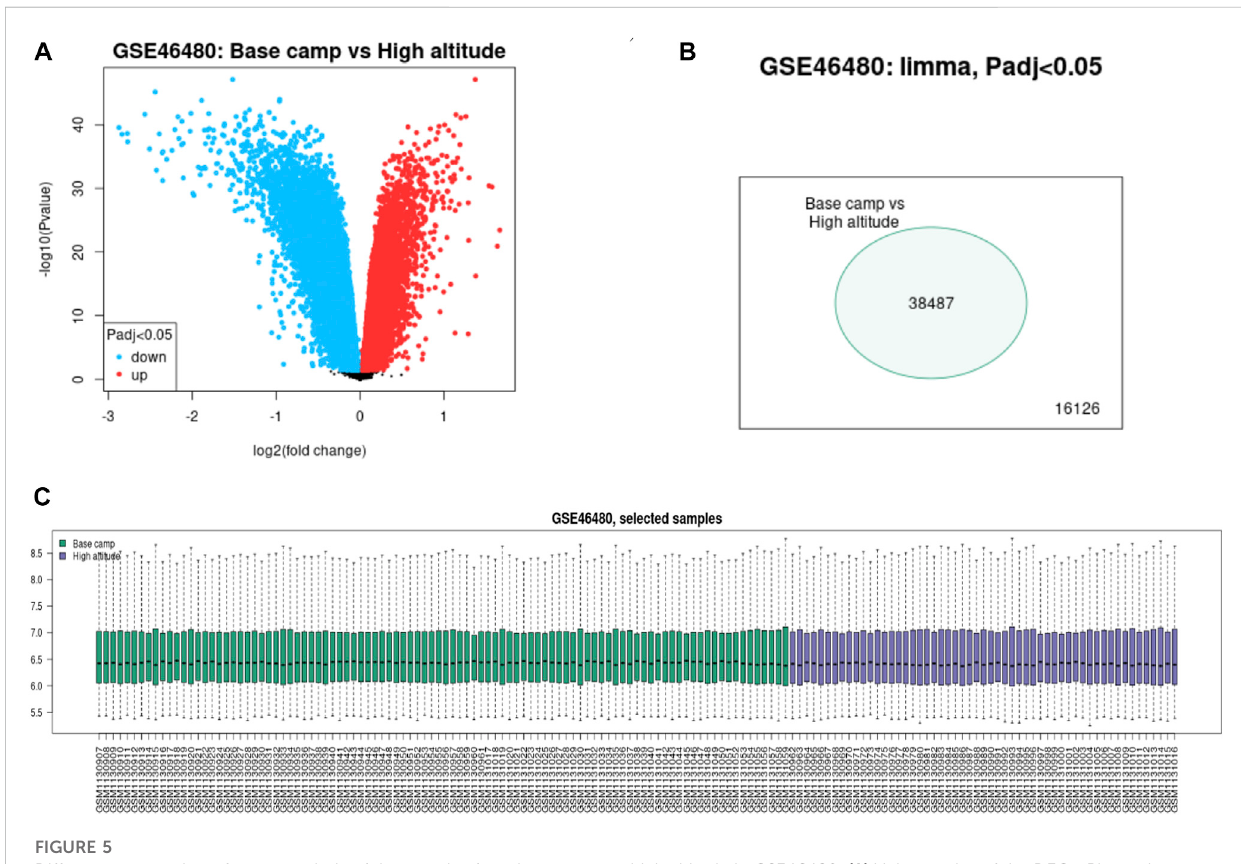
FIGURE 5 Difference expression of genes analysis of the samples from base camp to high altitude in GSE46480. (A) Volcano plot of the DEGs. Blue points represent downregulated genes. Red points represent the upregulated genes. (B) Venn diagram of the differentially expressed probe in GSE46480. (C) Quality control of the samples of